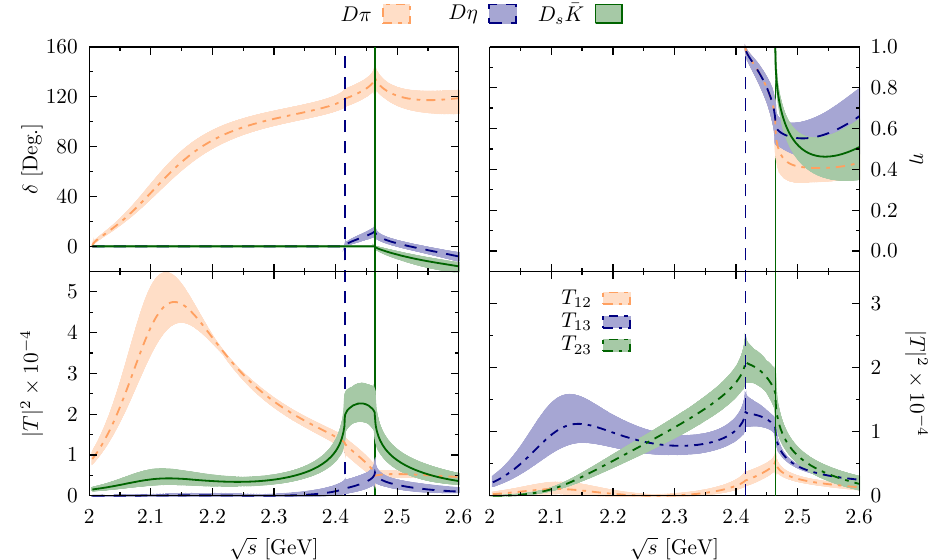
( 0 , 1 / 2 ) in the charm sector. The vertical lines indicate the D η and D s ¯ K thresholds. U